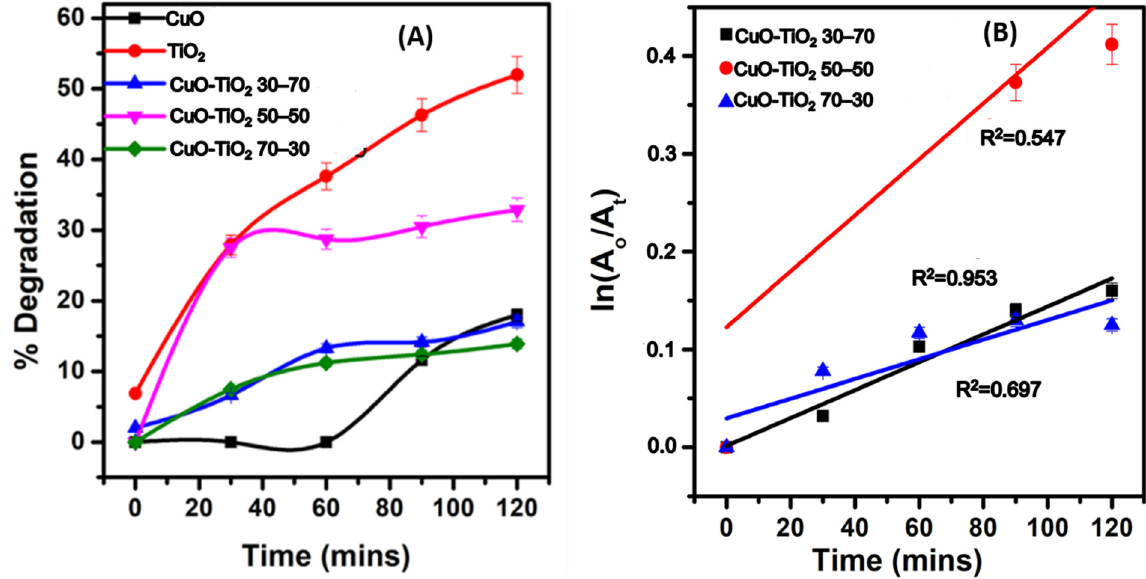
Figure 10. ( A ) Photodegradation of MB by CuO, TiO 2, and various ratios of CuO ‐ TiO 2 and ( B ) kinetics study of the CuO ‐ TiO 2.